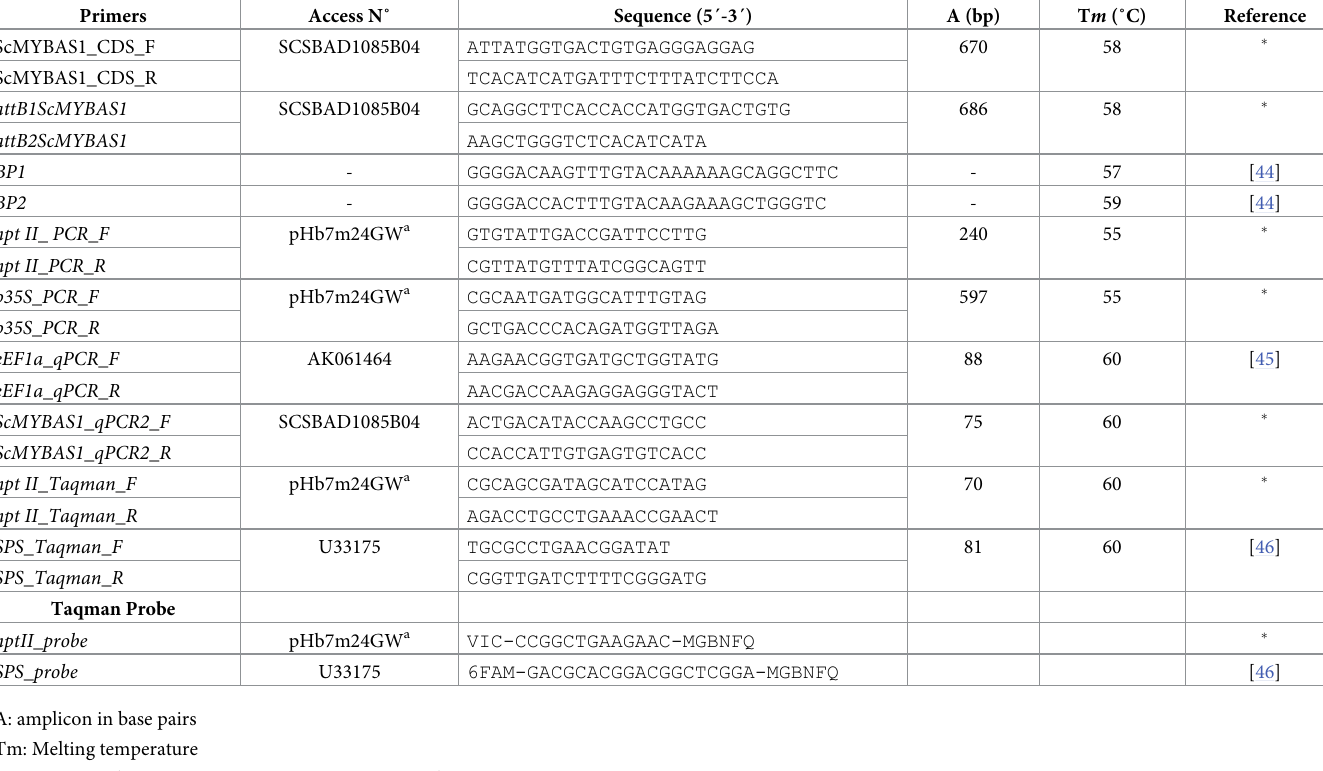
Table 1. Information and characteristics of the primers used in CDS (Coding Domain Sequence) amplification of ScMYBAS1 for functional analysis; insertion of Gateway sites; analysis of expression in transgenic plants; confirmation of transgenics; and estimate the copy number of the transgene.